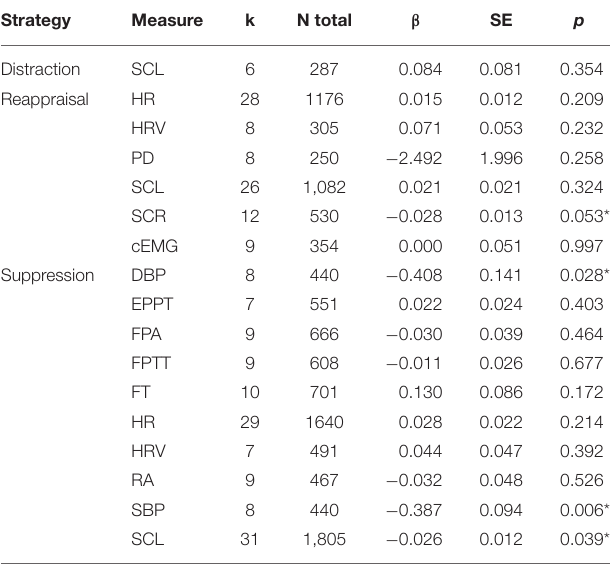
TABLE 8 | Moderator analyses on trial